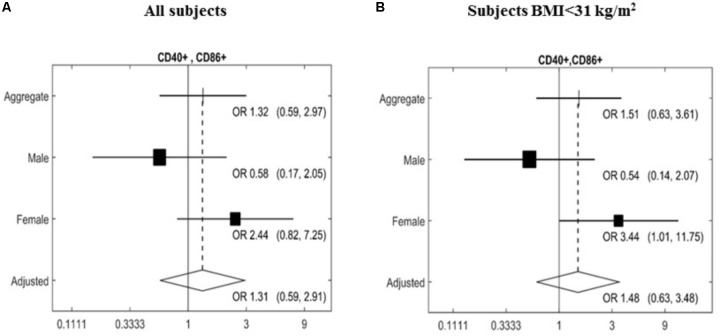
Effects of MedDiet on CD40+CD86+ expression following in vitro challenge with TLR agonists. PBMC were cultured with a cocktail of TLRs agonists (PolyA:U, Imiquimod, ODN-M362, LPS, Pam2CSK4) for 22 h. Forest plot of the study of the CD40+CD86+ lymphocytes comparing the association between Mediterranean diet and normal diet after 1 year of intervention with the random effect model. Associations were investigated based on an adjusted Mantel–Haenszel odds ratio (OR), stratified by gender (A) or BMI > 31 kg/m2
(B). OR and 95%Cl were calculated. Cl, confidence interval.